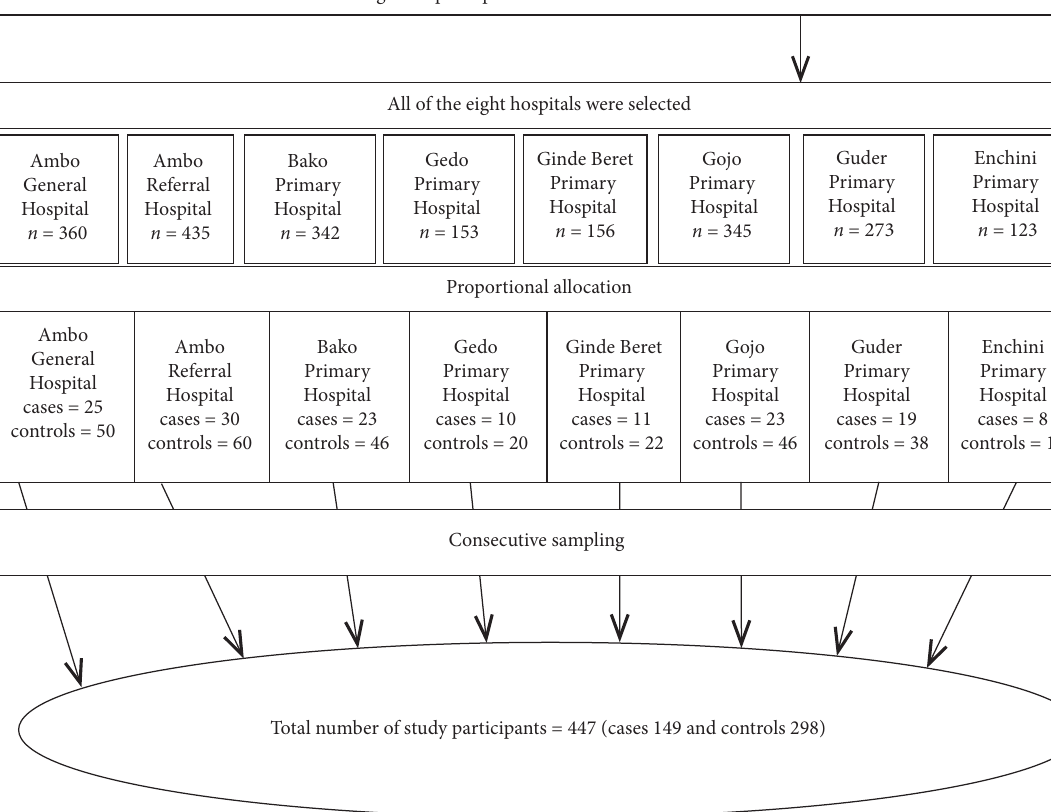
Figure 1: Schematic representation of pregnant women attending ANC in public hospitals of West Shewa zone from February to April